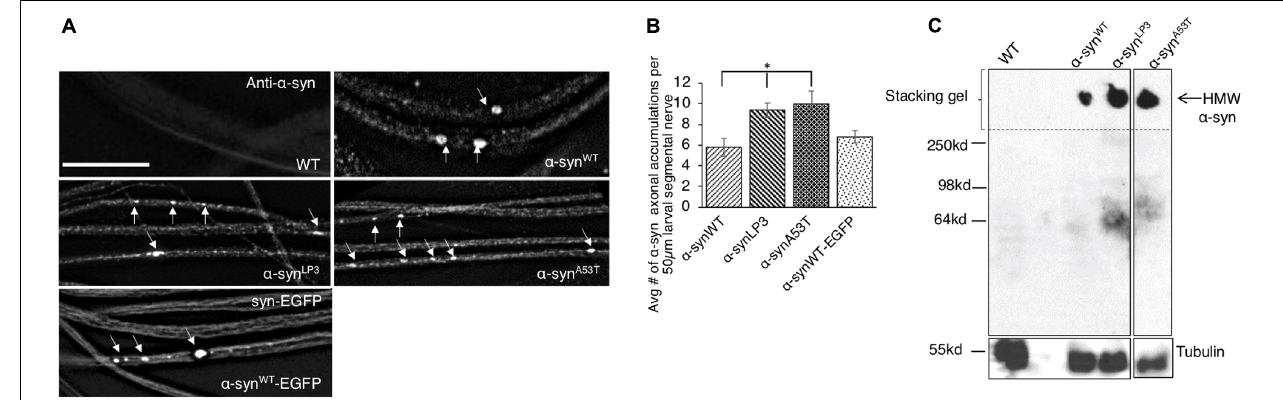
FIGURE 1 | Excess human α -syn accumulates in larval axons in vivo and forms higher molecular weight α -syn species. (A) Expression of human wild-type α -syn ( α -syn WT ), a human α -syn line that expresses at higher levels ( α -syn LP3 ), fPD α -syn mutant A53T ( α -syn A53T ), or EGFP tagged wild type α -syn ( α -syn WT -EGFP) in larval segmental nerves show α -syn accumulations (arrows). Wild-type (WT) larvae do not stain for α -syn. (B) Quantitative analysis of the average number (#) of α -syn accumulations per 50 µ m larval segmental nerve shows a significantly higher number in α -syn LP3 ( p < 0.05) or α -syn A53T ( p < 0.05) larval axons compared to α -syn WT . Note that α -syn WT -EGFP and α -syn WT contain similar amounts of α -syn accumulations. Quantitative analysis represents mean ± SEM. ∗ p < 0.05, N = 7, bar = 25 µ m. (C) Western blots from native non-denaturing gel electrophoresis reveal higher molecular weight (HMW) insoluble α -syn (arrow) in the stacking gel.